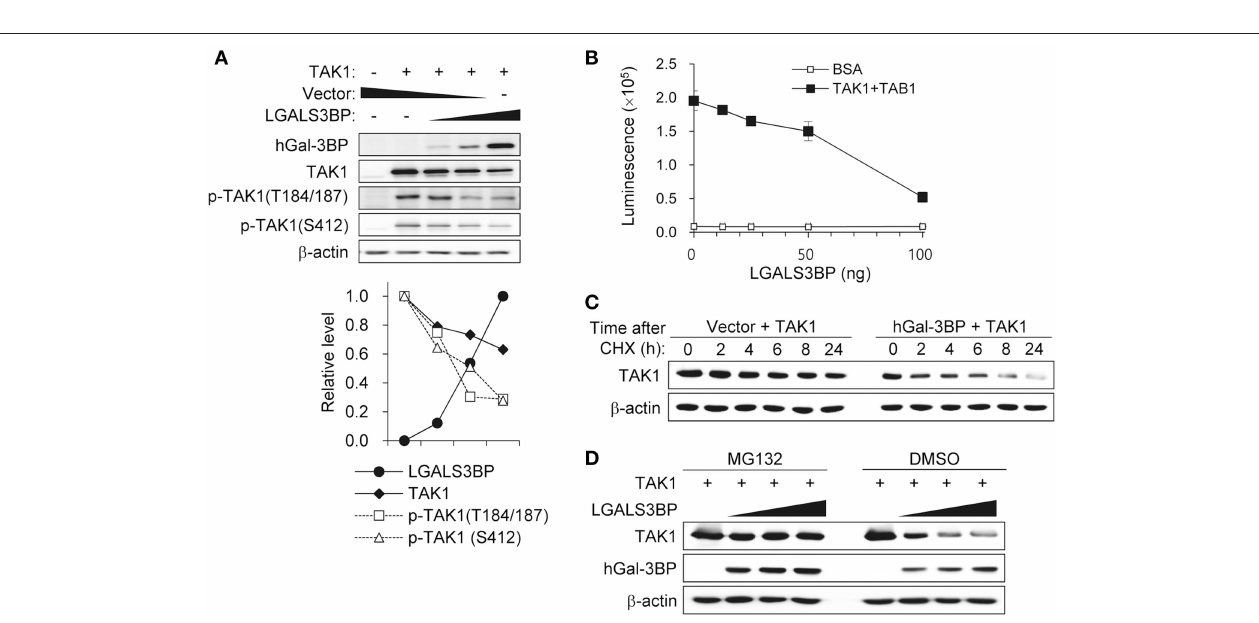
FIGURE 5 | Gal-3BP promotes TAK1 degradation and inhibits its activation. (A) HEK293T cells were transfected with TAK1 and different concentrations of LGALS3BP expression plasmids. The expression and activation levels of the transfected plasmids were confirmed by Western blotting. Quantification of relative protein expression is shown in the bottom panel. (B) The kinase assay for TAK1 was evaluated as described in the Materials and Methods. BSA was used as a control. Data are presented as the mean ± SD. (C) HEK293T cells were transfected with TAK1 and vector control or LGALS3BP expression plasmid. After 24h post-transfection, cells were treated with 20 µ g/ml cycloheximide (CHX) for the indicated times, and TAK1 levels were measured by Western blotting. (D) HEK293T cells were transfected with TAK1 , vector control or LGLAS3Bp expression plasmid. After 16h post-transfection, 10 µ M MG132 were treated for 6h. TAK1 and hGal-3BP were detected by Western blotting. β -actin was used as loading control.